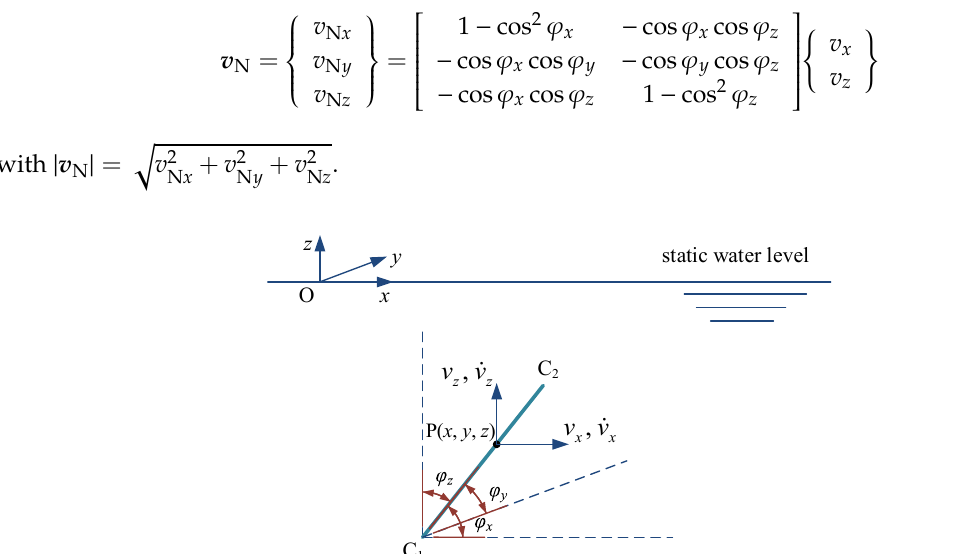
Figure 1. Wave-particle velocities and accelerations at point P( x , y , z ) on cylinder C 1 C 2 .